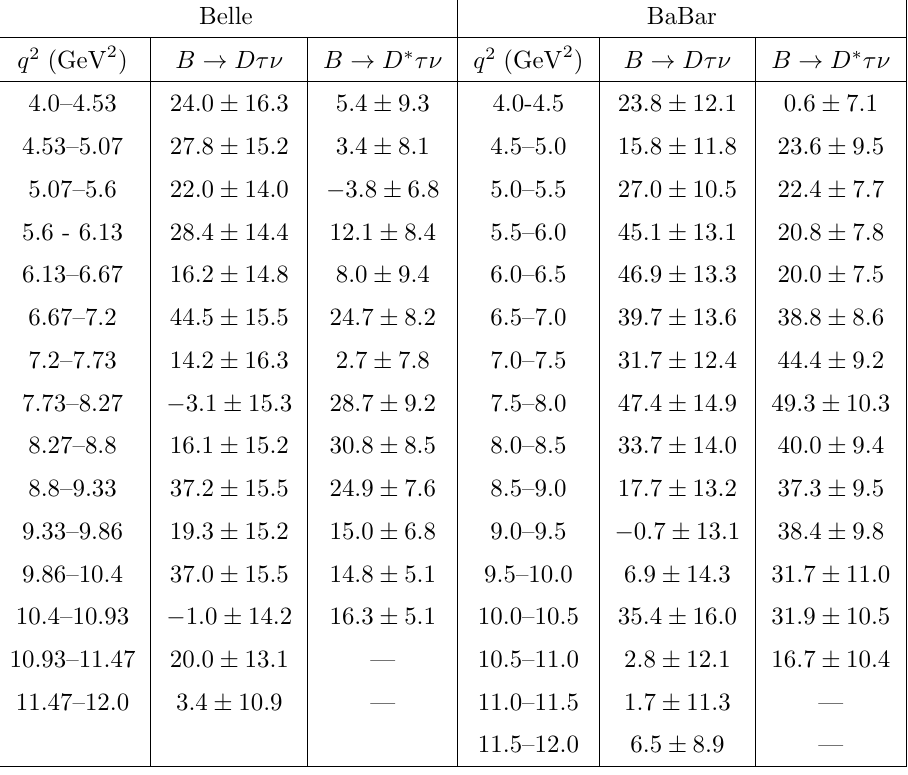
Table 9 . Measured q 2 distributions for B